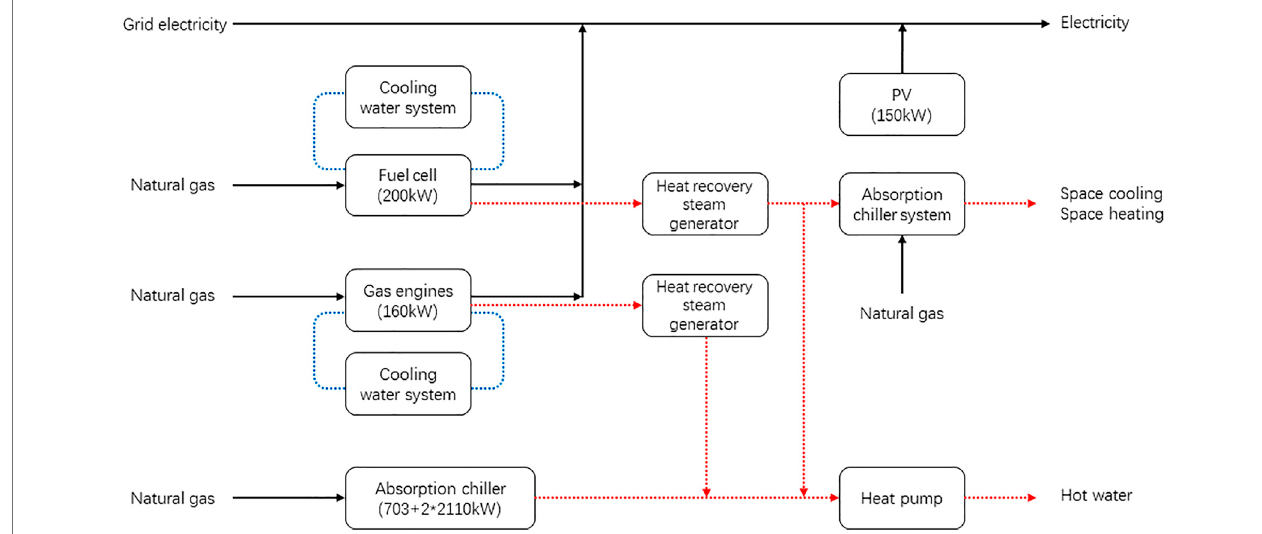
FIGURE 3 | The basic schematic diagram of the CCHP system at KSRP.